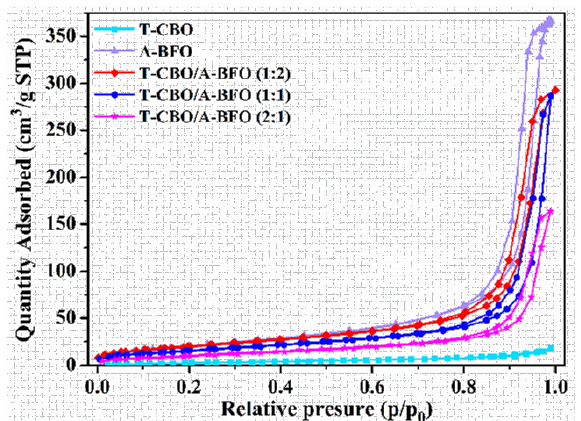
Figure 5. N 2 adsorption-desorption isotherms of the T-CBO, A-BFO, T-CBO/A-BFO (2:1), T-CBO/A-BFO (1:1), and T-CBO/A-BFO (2:1) composites.